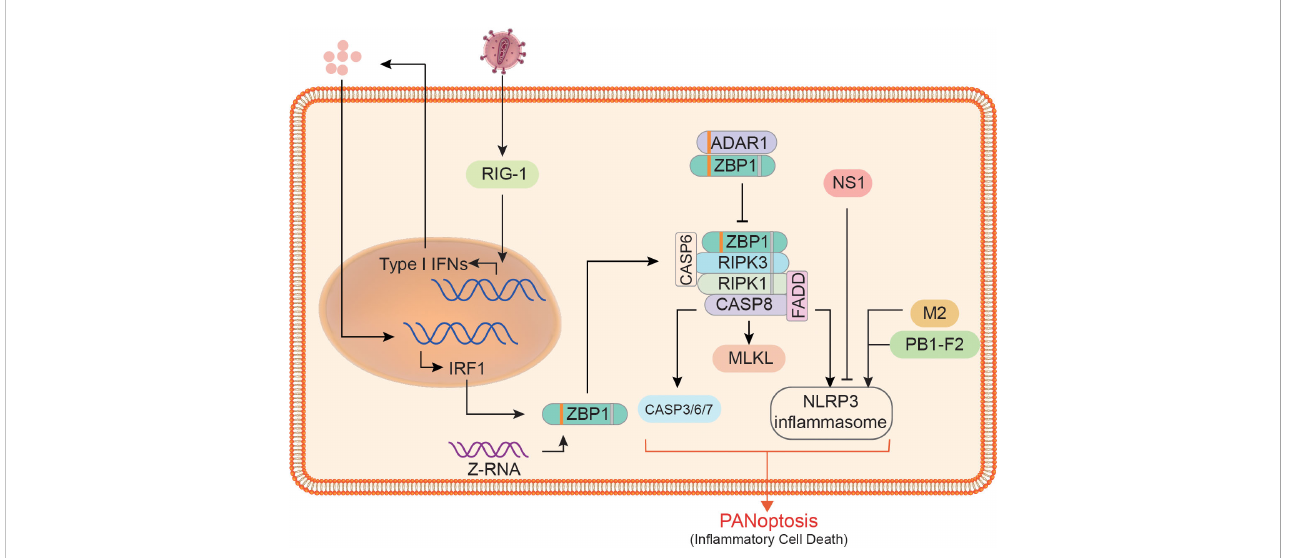
FIGURE 3 Regulation of ZBP1 PANoptosome formation and downstream effector activity. At the expression level, ZBP1 is affected by RIG1, type I IFN, and IRF1. At the assembly level, ADAR1 limits the interaction between ZBP1 and RIPK3, whereas CASP6 does the opposite. The downstream of ZBP1 PANoptosome, the activities of pyroptosis, apoptosis, and necroptosis executors are affected by many factors. For example, non-structural protein 1 (NS1), matrix protein 2 (M2), and PB1-F2 can affect the activation of the NLRP3 in fl